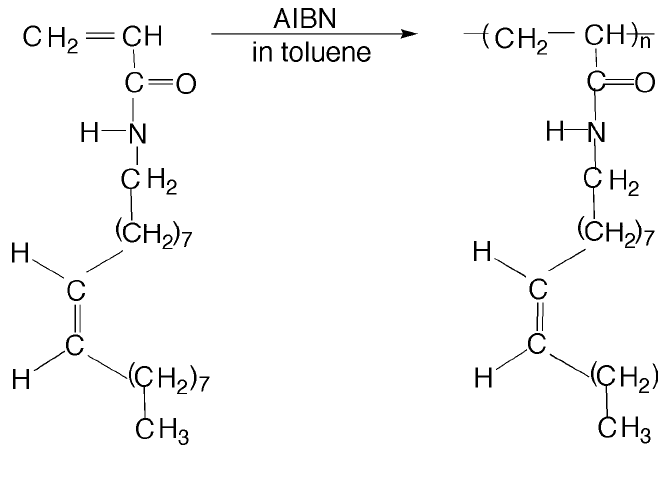
Figure 12. Preparation of